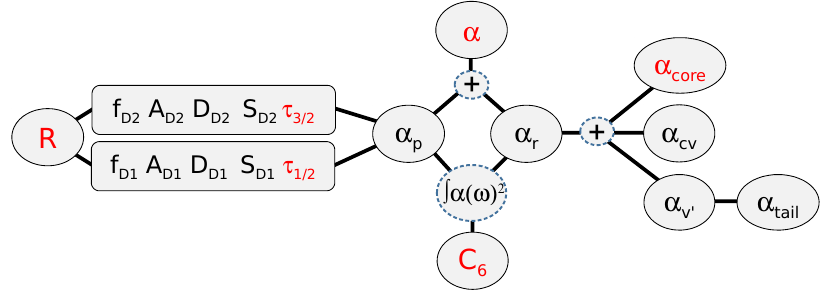
Figure 1. An idea chart showing connections between various quantities defined in Equations (1)–(17) that we relate to static polarizability α ( 0 ) for alkali metal atoms. Quantities in red have been directly measured. In this chart, as well as in this paper, α refers to polarizability in general, while α ( ω ) indicates dynamic (i.e., frequency-dependent) polarizability and α ( 0 ) indicates static polarizability. Polarizability (static or dynamic) can be written as the sum of principal ( α p ) and residual ( α r ) components, and the residual components themselves can be written as the sum of the polarizability of the inner-shell electrons ( α core ), contributions from excitations to higher valence states and continuum states ( α v (cid:48) ), and a core-valence coupling term ( α cv ). The van der Waals C 6 coefficient can be calculated by integrating the square of the dynamic polarizability over all frequencies ω . For alkali atoms, the principal component of polarizability can be written in terms of the oscillator strengths ( f ), Einstein A coefficients ( A ), dipole transition matrix elements ( D ), line strengths ( S ), or lifetimes τ associated with the atoms’ ns 1/2 − np 1/2 and ns 1/2 − np 3/2 transitions (where n = 2 for Li, n = 3 for Na, and so forth), also known as the D 1 and D 2 transitions. Line strength ratios R can be used to relate pairs of f , A , D , S , or τ